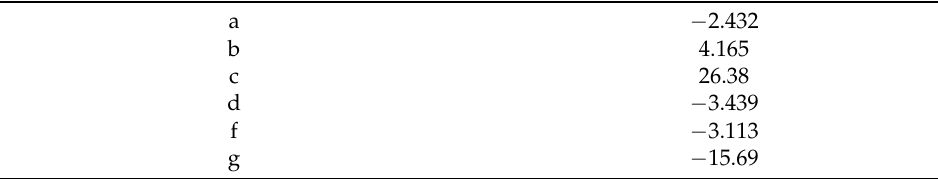
Table 9. Coefficients for the fitting fuction of the male model.